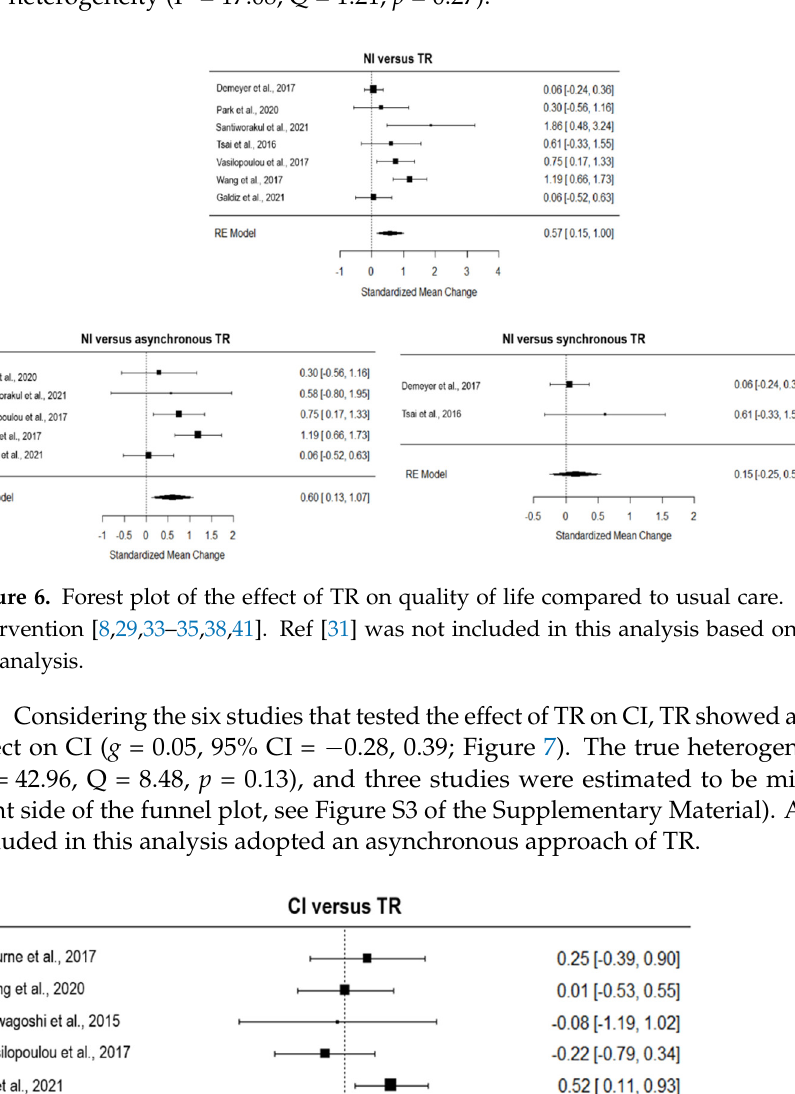
Figure 7. Forest plot of the effect of TR on quality of life compared to conventional intervention. CI, conventional intervention; TR, TR [8,24–26,36,37].